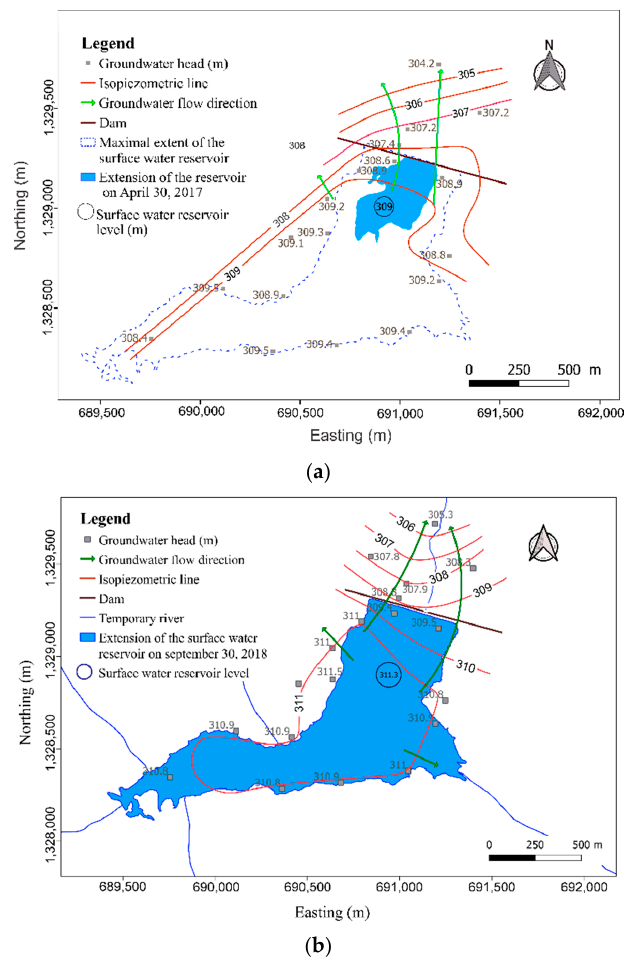
Figure 7. Piezometric map for dry ( a ) and rainy ( b ) seasons within Kierma watershed based on measurements from 20 micropiezometers and SWR level.